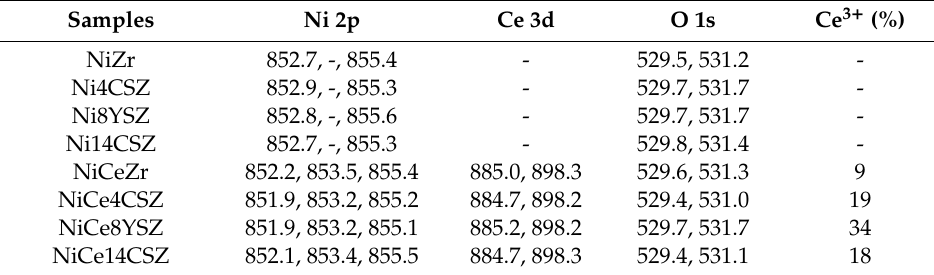
Table 4. Binding-energy values of main peaks and the Ce 3 + percentage from